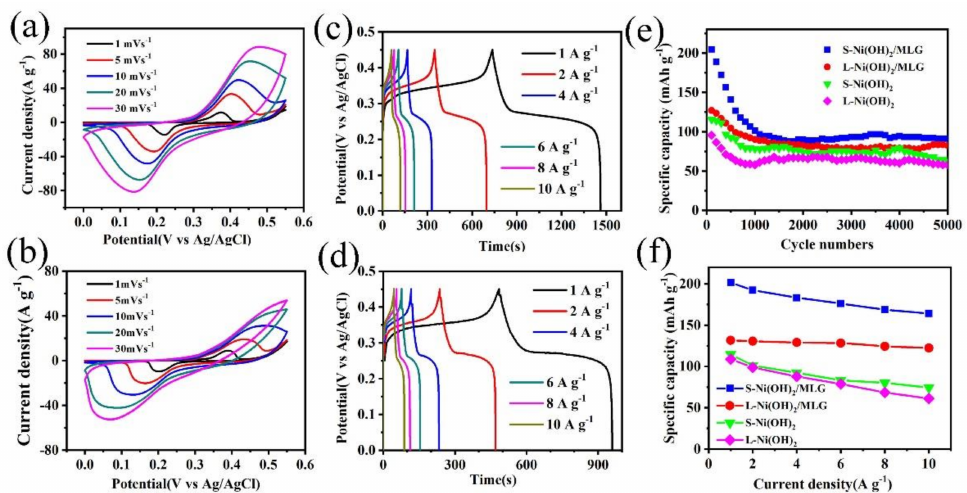
Figure 6. Electrochemical performances of electrodes, cyclic voltammetry (CV) curves of S- Ni(OH) 2 /MLG ( a ) and L-Ni(OH) 2 /MLG ( b ) from a scan rate of 1–30 mV s − 1 , galvanostatic charge- discharge (GCD) curves of S-Ni(OH) 2 /MLG ( c ) and L-Ni(OH) 2 /MLG ( d ) at a current density of 1–10 A g − 1 , ( e ) Specific capacities at various current densities. ( f ) Cycling performance at a current density of 4 A g − 1